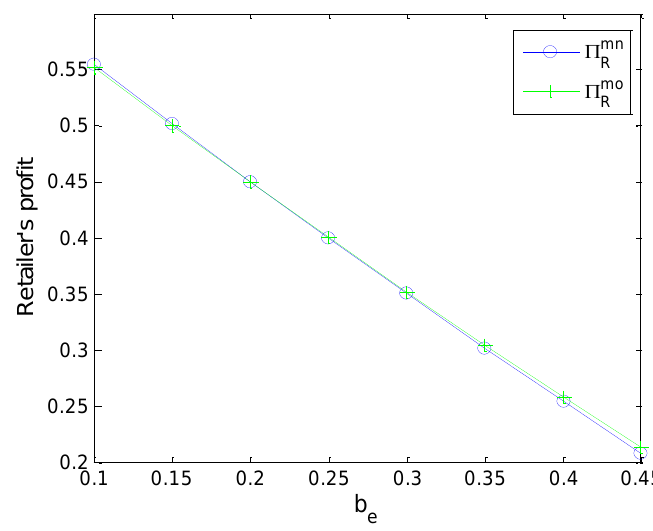
Figure 4. Impact of 𝑏 𝑒 on retailer’s profits under monopoly case.